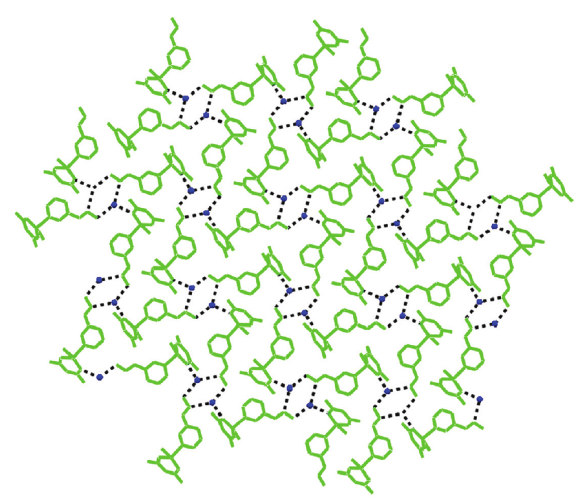
Figure 2: A part of the 2D network in the crystal lattice of 1 · H 2 O due to hydrogen bonding interactions (dashed lines). Oxygen atoms of the water lattice molecules are represented by blue spheres.